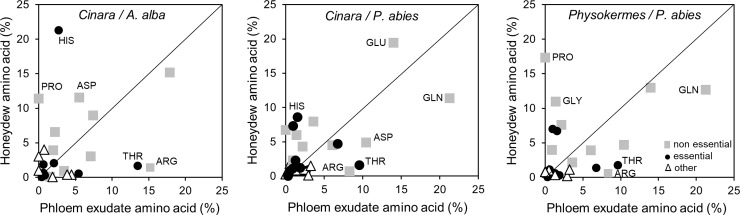
Amino acids in phloem exudate and honeydew, each expressed as percentage of the total amino acid concentration.Cinara species feeding on A. alba, Cinara species feeding on P. abies, and Physokermes species feeding on P. abies. The data show means across both species of a hemipteran genus feeding on the same tree species for the proportion of amino acids in honeydew (data from Table 2). Grey squares: non-essential amino acids, black circles: essential amino acids, white triangles: other organic amino compounds. Points with the highest orthogonal distance to the bisecting line were noted.